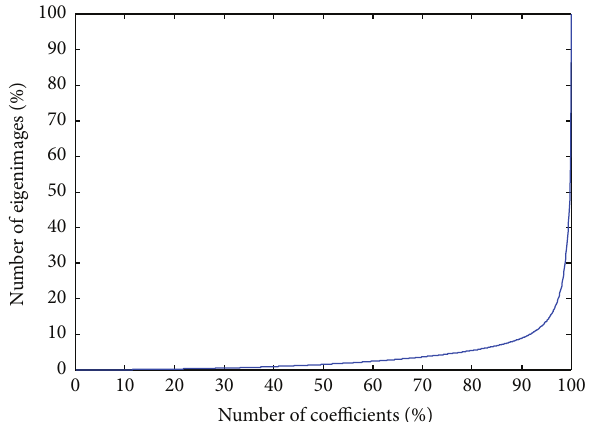
Figure 7: Cumulative sum of the eigenvalues versus number of used KLT coefficients. Eigenvalues are sorted from the least to the most significant. M17.dat